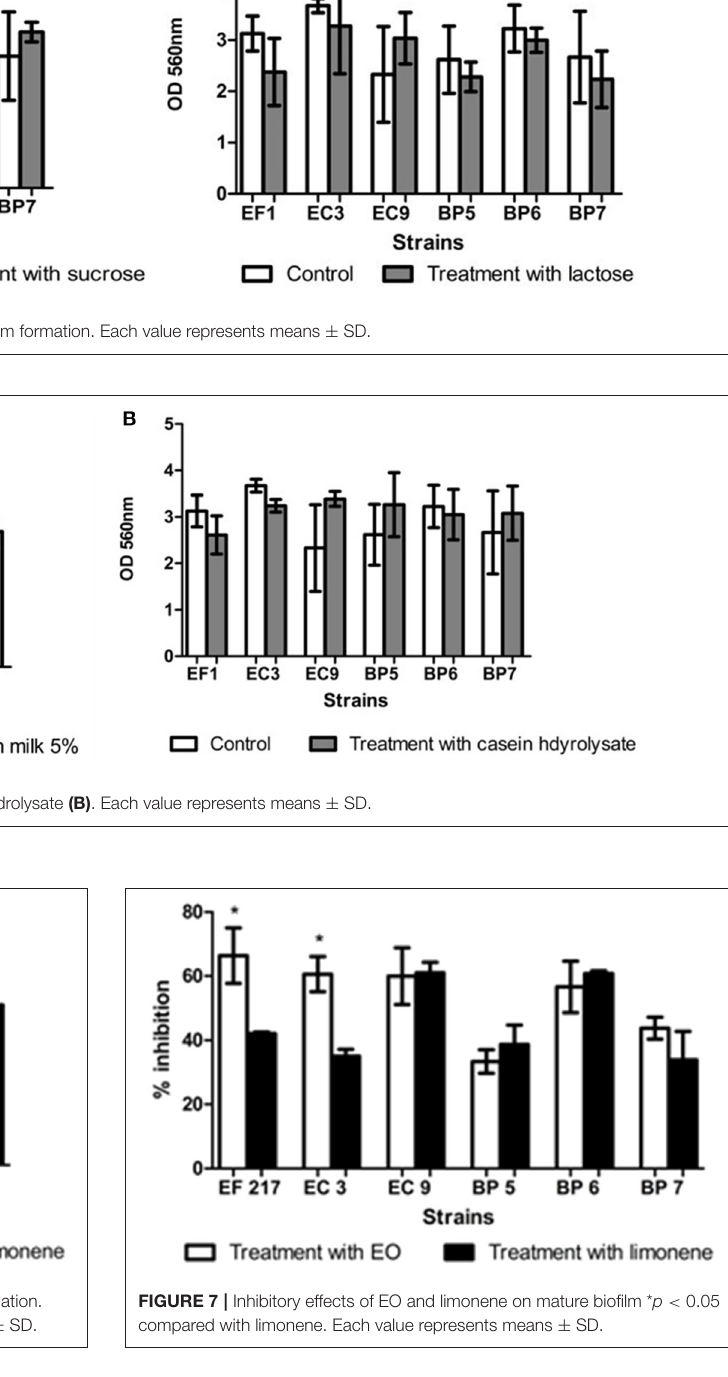
milk samples where four of them were B. pumilus. Similarly, Amer et al. (24) found Bacillus spp. in 22.1% of isolates. The presence of Bacillus spp. may risk the quality guarantee of milk products.